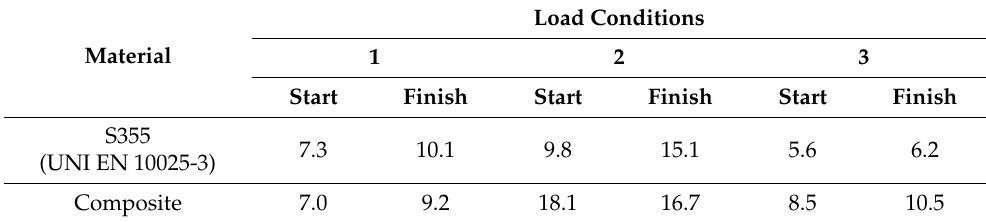
Table 4. Maximum displacements [mm] for the steel and composite arms.